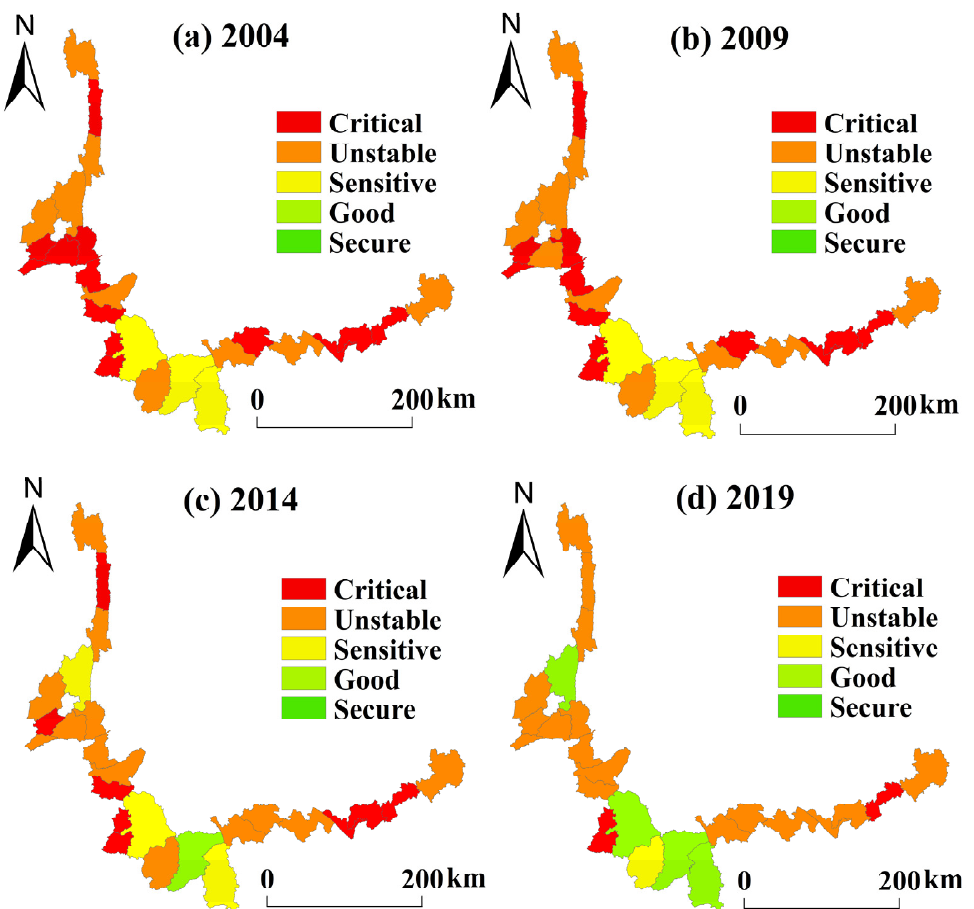
Figure 4. Spatial change in ecological security in 25 border counties in Yunnan Province, China for: ( a ) 2004; ( b ) 2009; ( c ) 2014; and ( d ) 2019. Note: Maps were created by authors using ArcGIS 10.7. Based on the evaluation of ES in 2004, 2009, 2014, and 2019, the Geostatistical Analyst tool in ArcGIS 10.7 was applied to visualize the spatial representation of ES